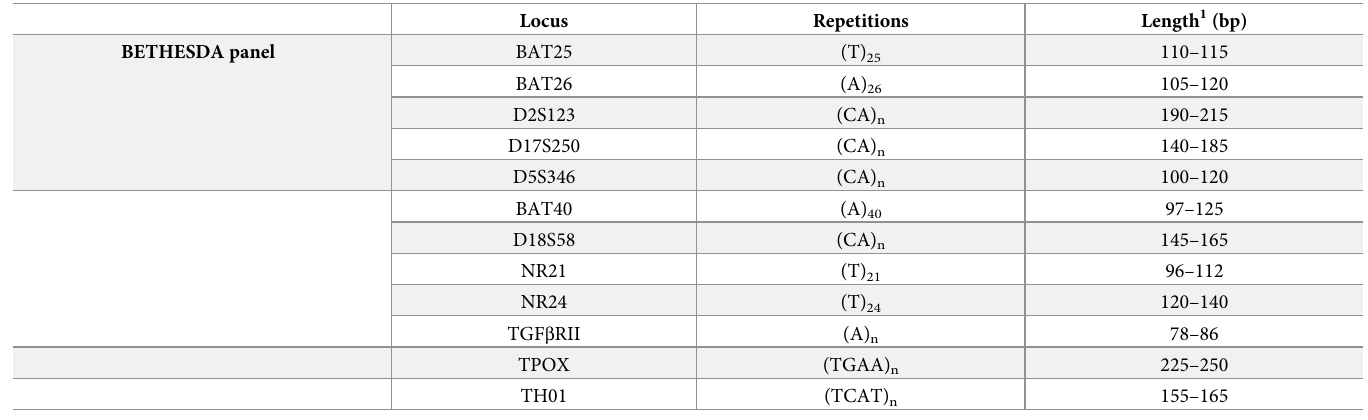
Table 1. The different microsatellite loci analyzed.